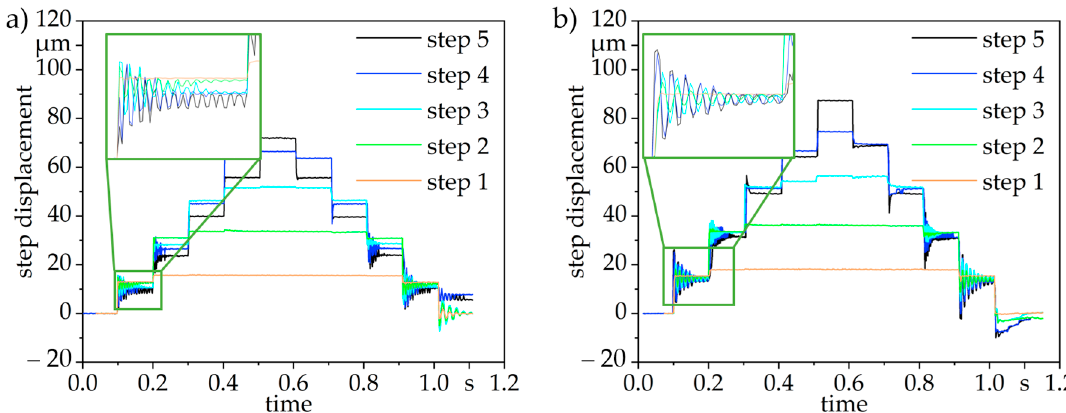
Figure 12. Time-dependent displacement of the single steps at step-by-step activation of ( a ) system 1, ( b ) system 2.